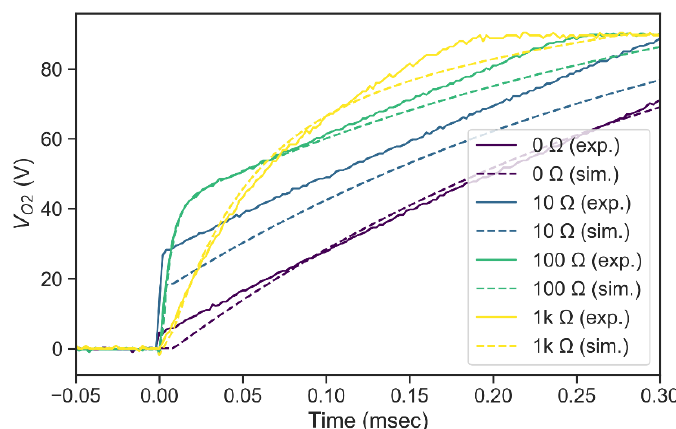
Figure 10. Comparison of experimental and SPICE simulated voltage waveform with load of capacitors.